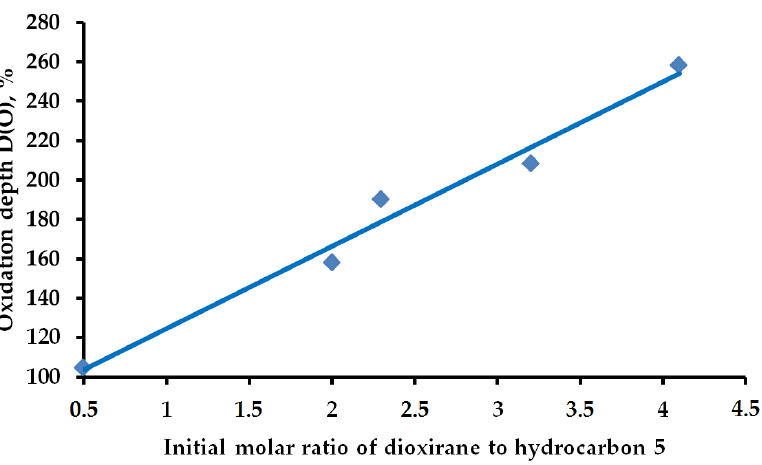
Figure 3. The dependence of D(O) on the initial molar ratio (MR) of dioxirane CH 3 (CF 3 )CO 2 to hydrocarbon 5 . The values of D(O) are calculated based on the percentage compositions of oxidation products 5 according to the data of the works [53,54]. Equation: D(O) = 41.724MR + 82.828, R 2 = 0.9783.